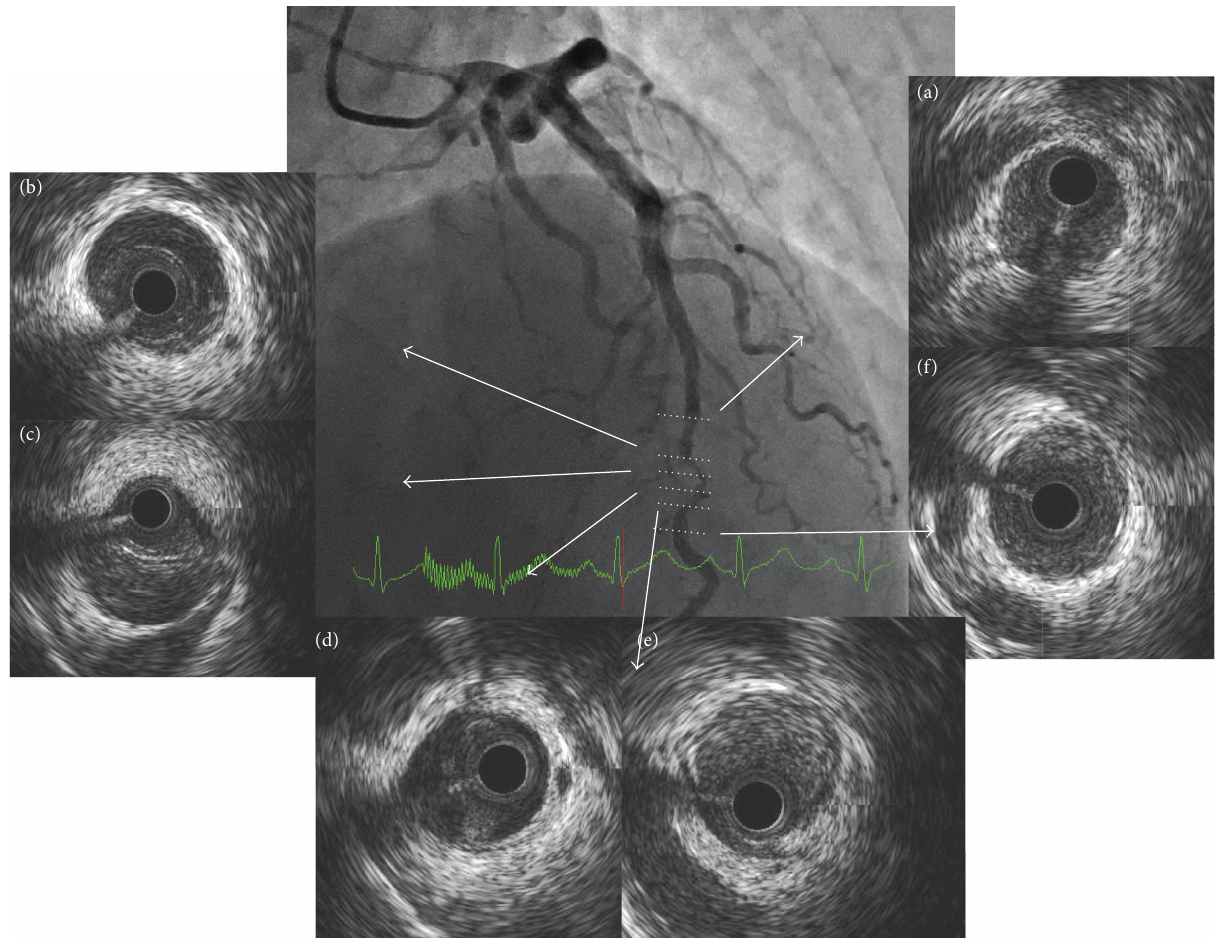
Figure 3: IVUS findings in the mid LAD on admission. Double lumen and an intramural hematoma were found (b–e). CAG: straight cranial